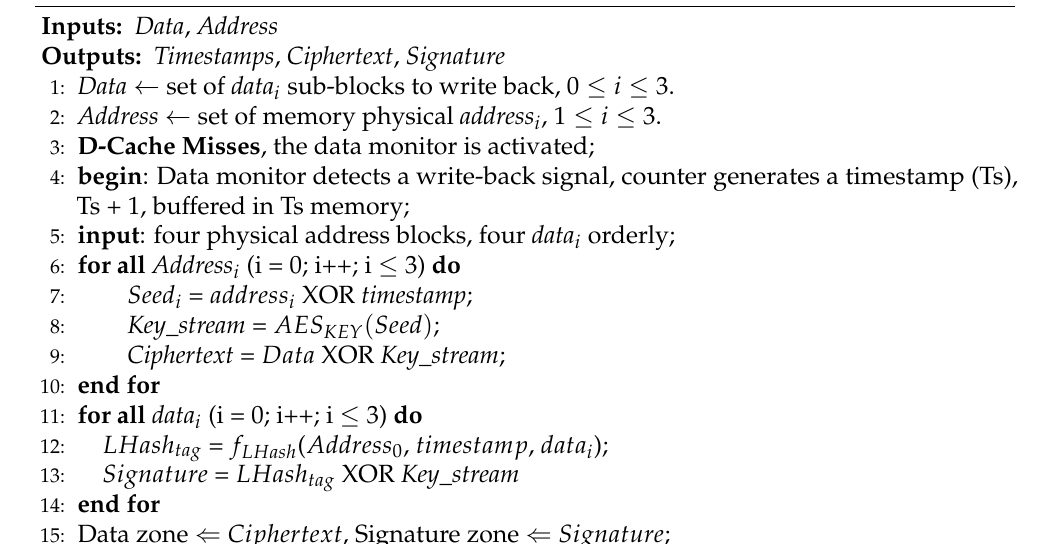
Algorithm 1 Write-back operation of 128-bit data block stored into external main